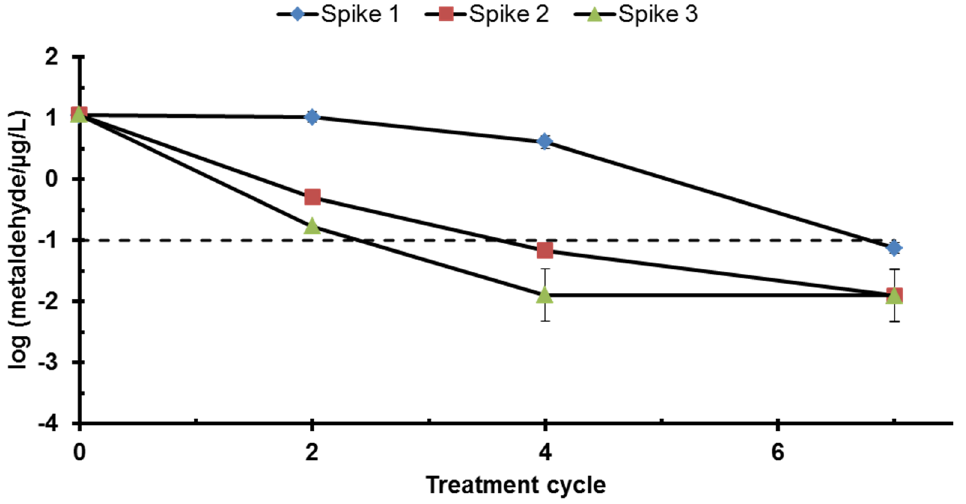
Figure 4. Metaldehyde remaining of triplicate spikes (initial concentration 11 µg/L) after successive treatment cycles. Mixing times, 15 min; regeneration times, 15 min; current, 0.5 A. Bars indicate the error, when they are not visible the error bar is smaller than